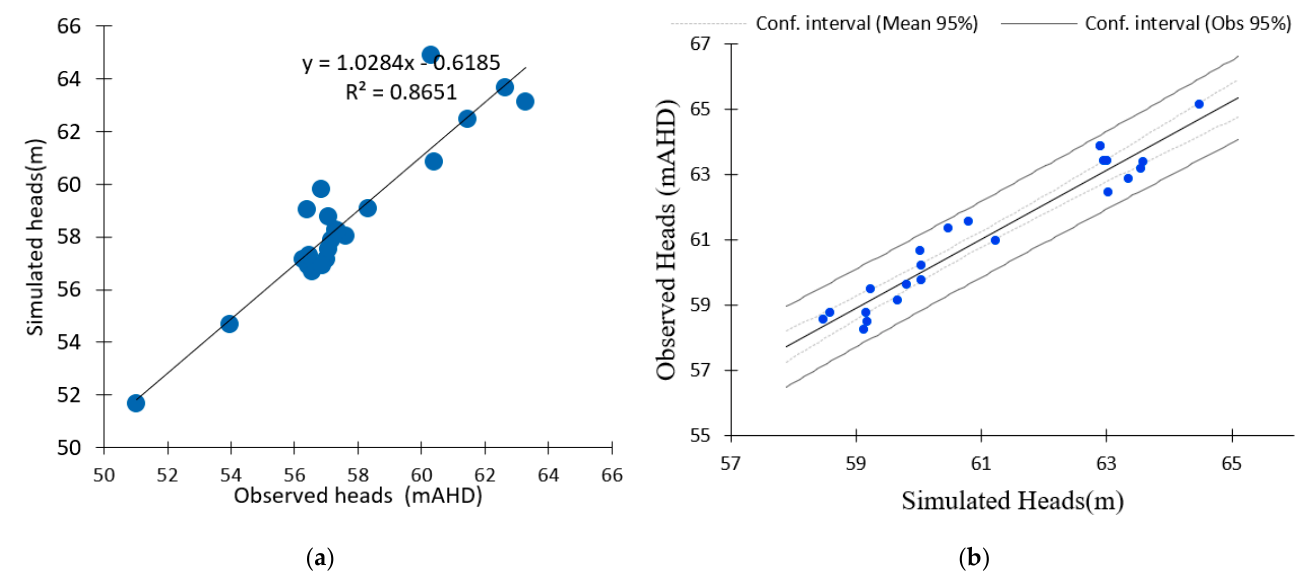
Figure 5. ( a ) Correlation between simulated and observed groundwater heads; ( b ) linear relationship between measured and Scheme 95. confidence intervals for the mean of the observed values and the observed values.